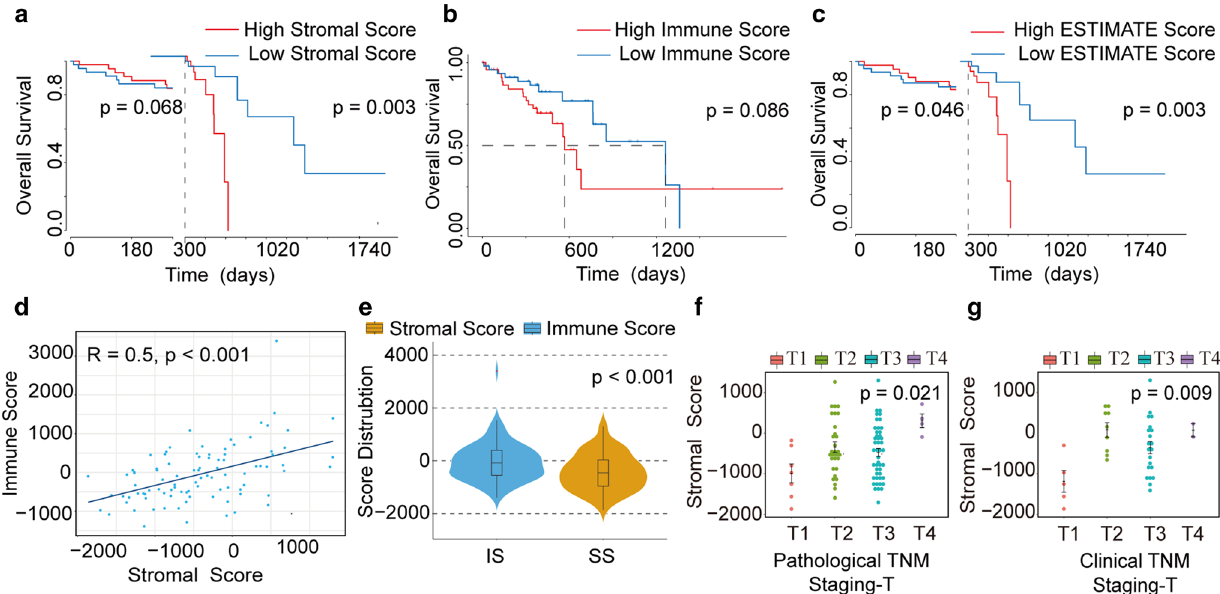
Fig. 1 Relationship between scores and clinical parameters of patients with ESCC. a Kaplan–Meier survival curve of landmark analysis between Stromal Score and overall survival of patients with ESCC. b Survival analysis with Kaplan–Meier method for ESCC patients grouped by Immune Score (Log-rank test). c Kaplan–Meier survival curve of landmark analysis between ESTIMATE Score and overall survival of patients with ESCC. d The analysis of correlation between Stromal Score and Immune Score (Person analysis). e The analysis of diversity between Stromal Score and Immune Score (Wilcoxon rank sum test). f – g Distribution of Stromal scores in T